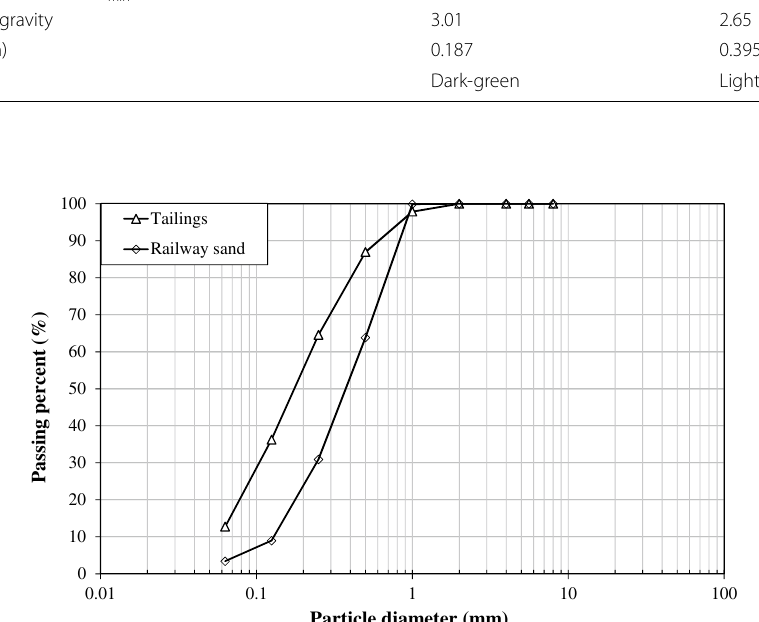
Fig. 2 Particle size distribution curves of the fine granular materials used in this